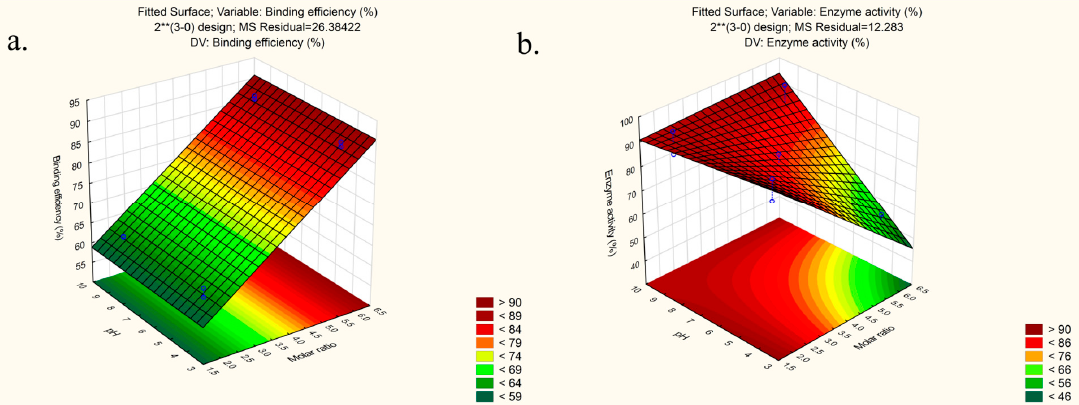
Figure 2. The response surfaces (temperature at zero level − 31 ◦ C) show the effect of the significant examined variables on the ( a ) binding efficiency and ( b ) enzyme